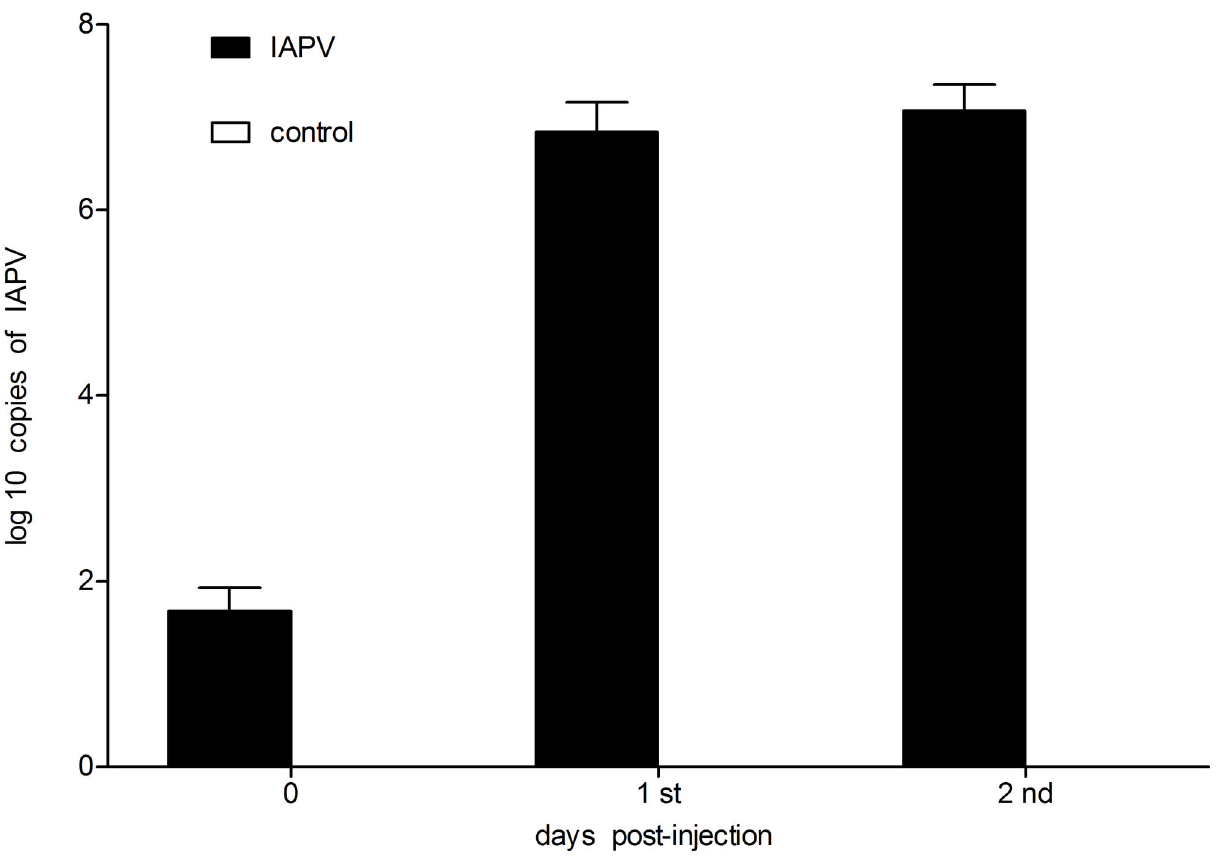
Figure 4. The exact number of copies of IAPV in heads of honey bees. The exact number of copies of IAPV in heads of honey bees collected at day 0, day 1 and day 2 after injections with 1 ul of IAPV (1: 200 dilution) and 1 ul of PBS respectively. Error bars show